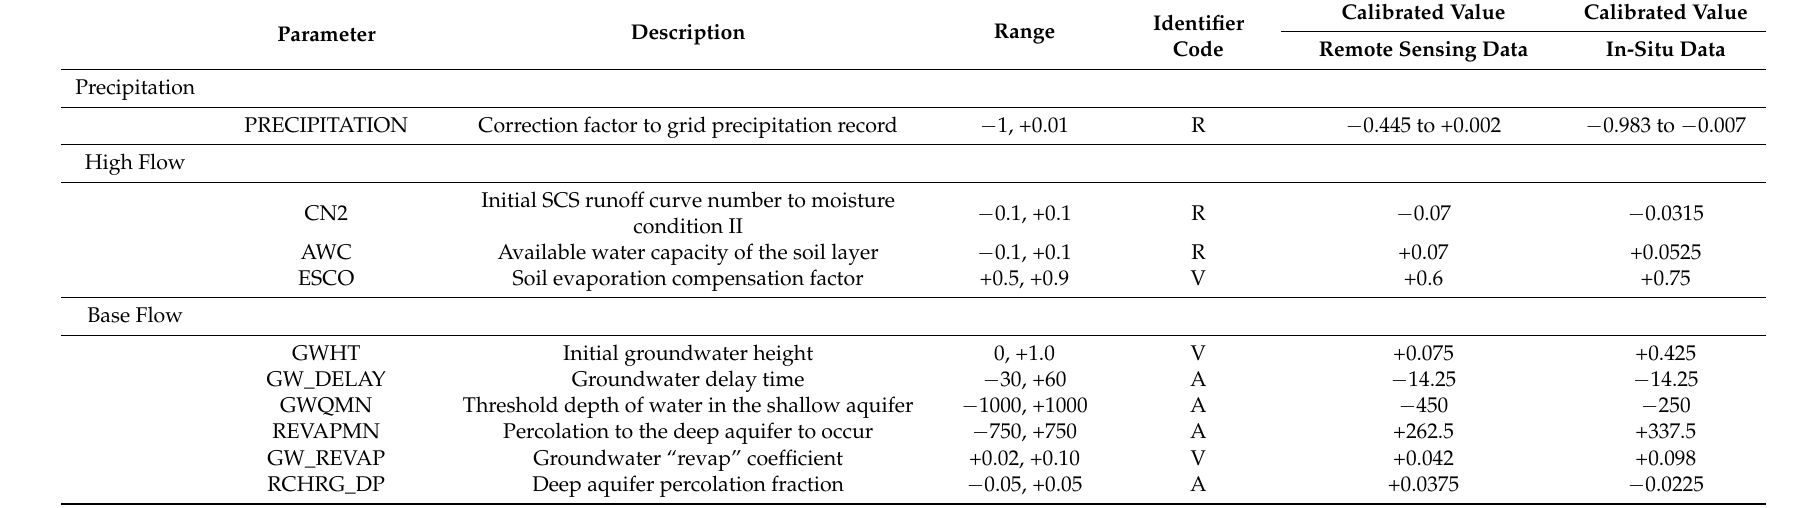
Table 2. Parameters and calibrated values used for the LMRB model simulations. The identifier code refers to replacement (V), addition (A), and multiplication